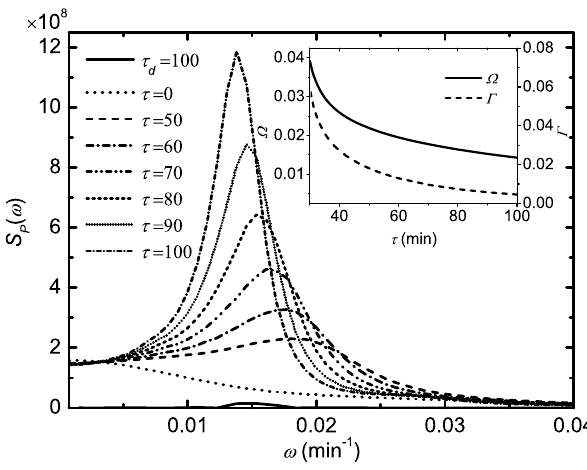
Figure 2. A plot of the average power spectrum S P ( v ) ~ v F P ( t ) ½ (cid:3)j j 2 w as a function of frequency v with ( t ~ 0 , (cid:2)(cid:2)(cid:2) , 100 min) and without ( t d ~ 100 min) noise, where F P ( t ) ½ (cid:3) is Fourier transform of p53 dynamics from the time to the frequency domain, and the p53 dynamics P ( t ) is obtained with the DSSA. Inset: V and C fitted with Eq. (14) vs. t . The other parameters are as in Fig.